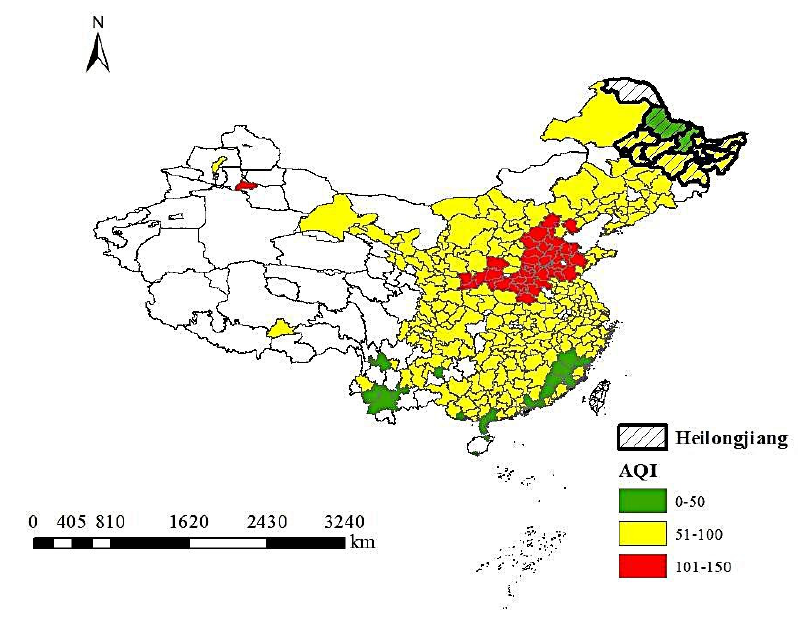
Figure 1. Spatial distribution of AQI in 283 cities for the period 2015–2017.